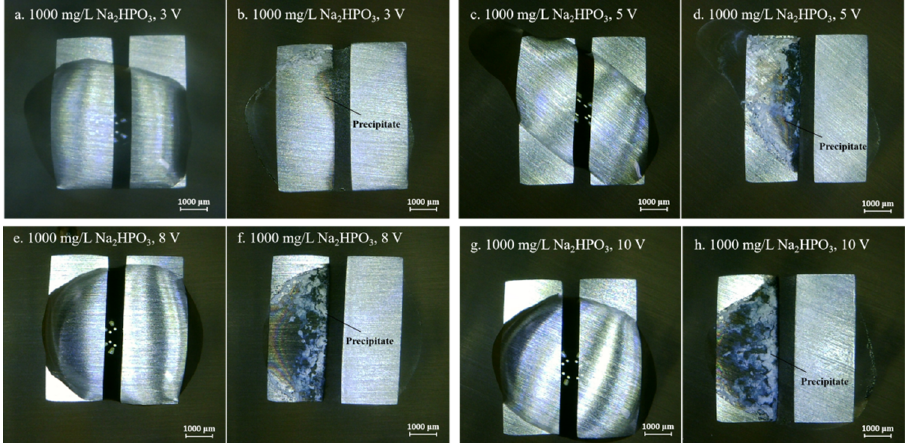
Figure 7. Optic photos for ECM tests of tin under a droplet of 15 μ L containing 500 mg/L Na 2 HPO 4 at various bias voltages (Anode is on the left and cathode is on the right).